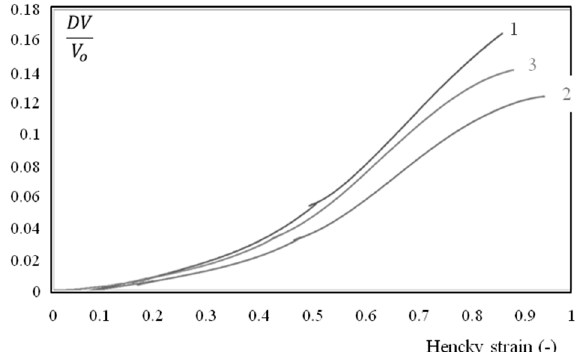
Figure 13. Volume deformation during a constant strain rate tensile test, for core (1), surface (2) and total thickness (3) specimens. The water content is 7% and samples were extracted from the first third of the plaque (close to the gate).